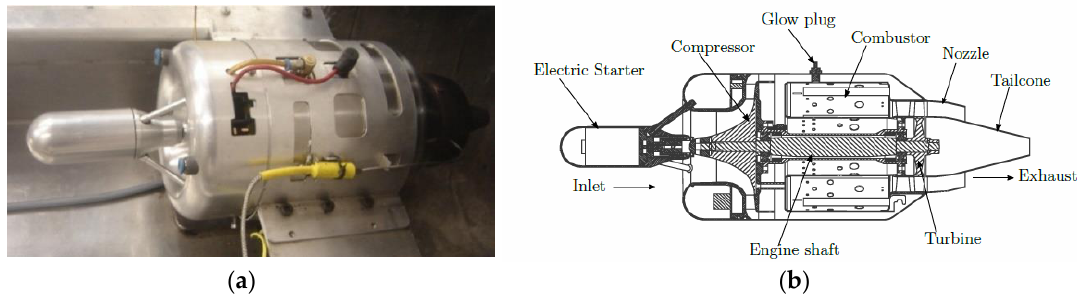
Figure 2. ( a ) Image of BMT 120 KS micro jet engine [6]; and ( b ) Schematic of BMT 120 KS.